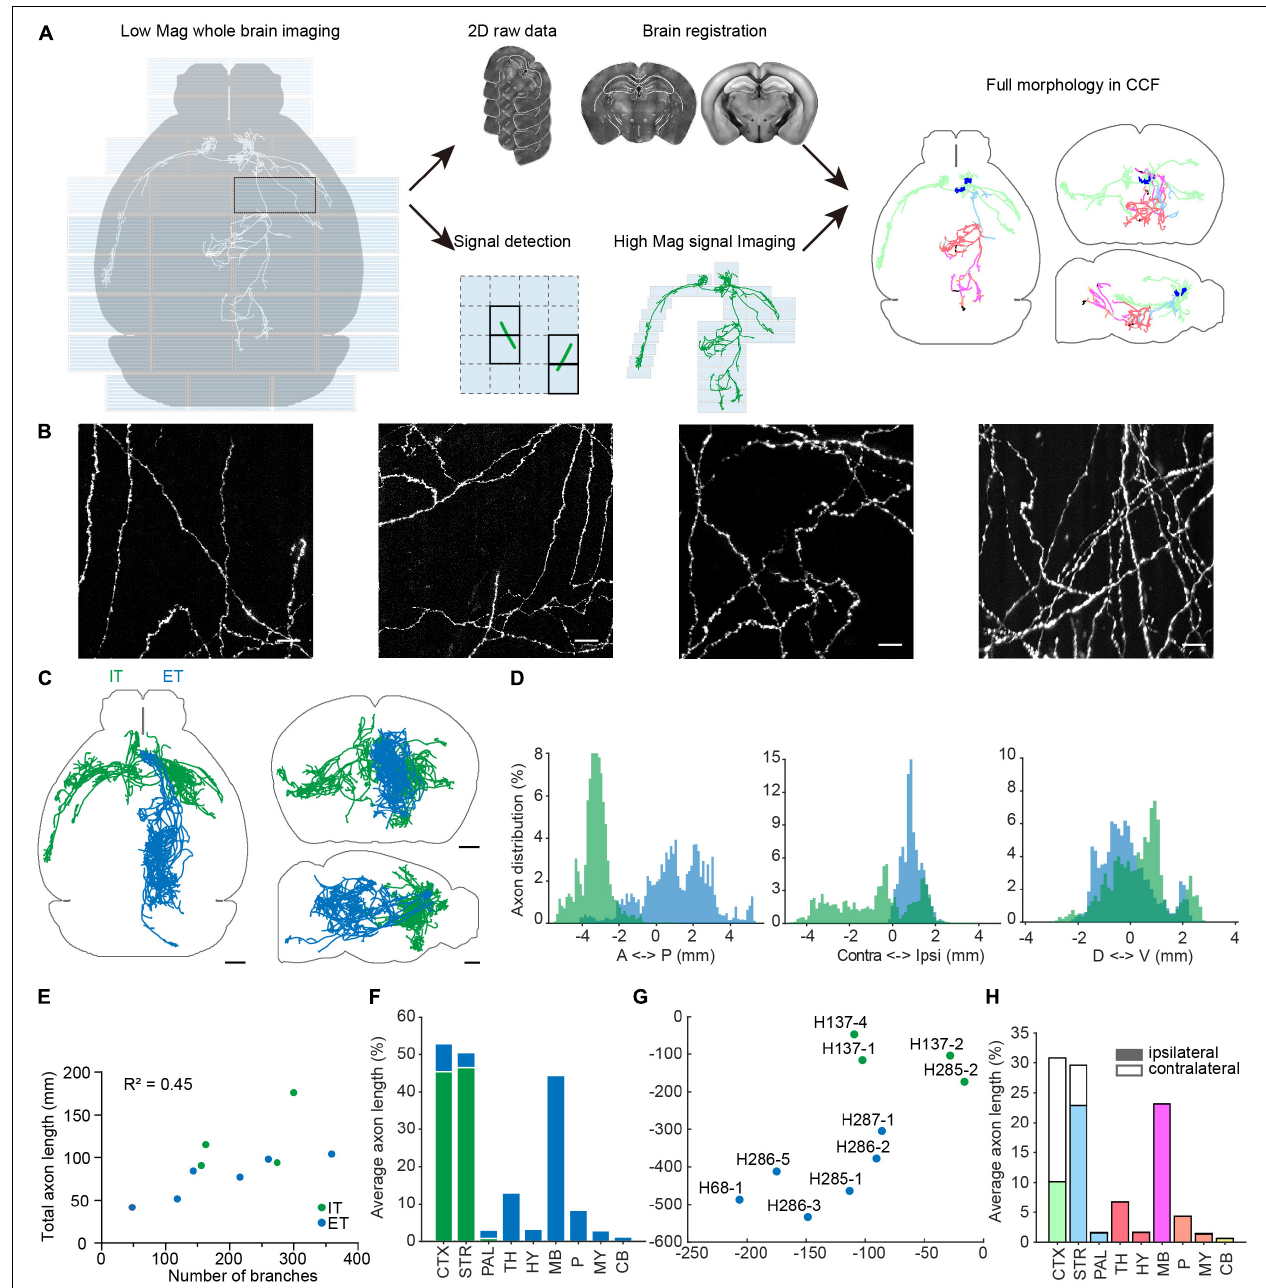
FIGURE 9 | Multi-scale whole brain imaging of sparsely labeled neurons in mPFC. (A) Schematic of multi-scale imaging. The process is decomposed into imaging with low magnification for signal detection and imaging signal areas with high magnification. By taking advantage of sparse signals, the efficiency of data acquisition was greatly improved. Finally, the low-magnification whole-brain data were registered to the CCFv3, and the same deformation field was used to register annotations acquired by high magnification. Gray, axonal process before registration. Color, morphology after transformation. Axons located in different brain areas are color-coded. CTX, cerebral cortex; STR, striatum; PAL, pallidum; TH, thalamus; HY, hypothalamus; MB, midbrain; P, pons; MY, medulla; CB, cerebellum. (B) Example images of axons from sparsely labeled neurons. (C) Overview of traced individual mPFC neurons ( n = 10). Green, intratelencephalic (IT) neurons; blue, extratelencephalic (ET) neurons. (D) Distribution of axons of mPFC IT and ET neurons along the anterior-posterior (AP), medial-lateral (ML), dorsal-ventral (DV) directions. Bregma is chosen as the origin along the AP and ML directions, while the centroid of the brain is chosen as the origin along the DV direction. (E) Relationship between total axonal length and number of branches. Same neurons as in (C) . (F) Brain-wide distribution of axonal processes of mPFC projection neurons. The axonal length in each area is normalized to the total axonal length. The sum of normalized axonal length does not reach 1, as there are en passant axons. (G) t-Distributed stochastic neighbor embedding (t-SNE) showing clustering of different projection neurons. (H) Distribution of axonal processes of reconstructed mPFC neurons in different cortical and subcortical areas. The axonal length in each area is normalized to total axonal length in the indicated areas. Scale bars, 50 µ m (B) , 1 mm (C)